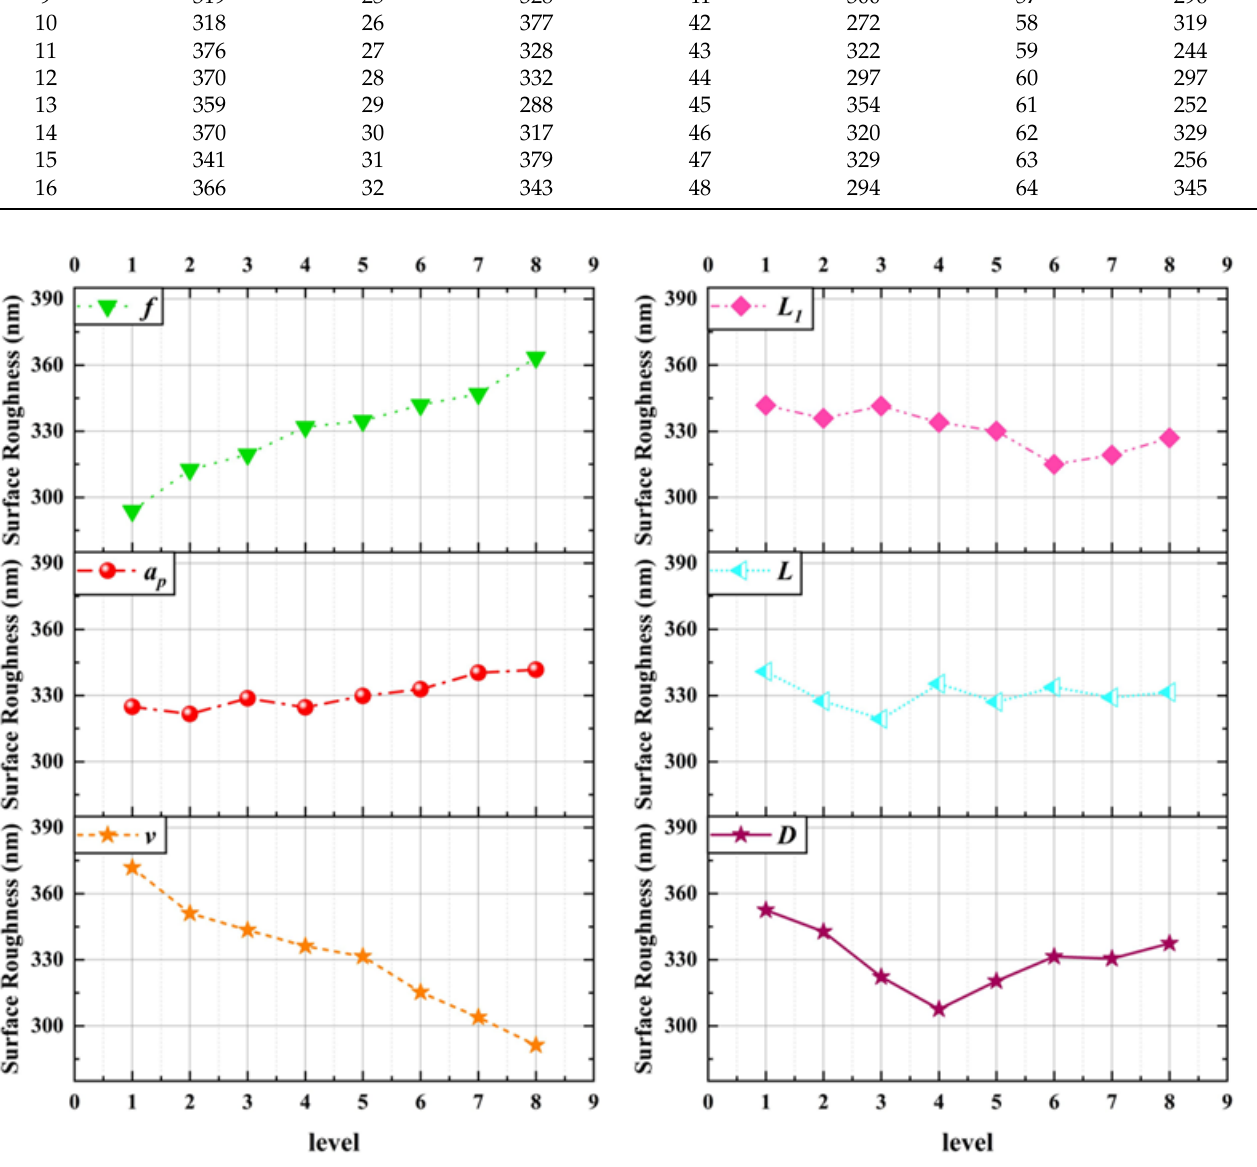
Figure 12. Analysis results of range of workpiece surface roughness.